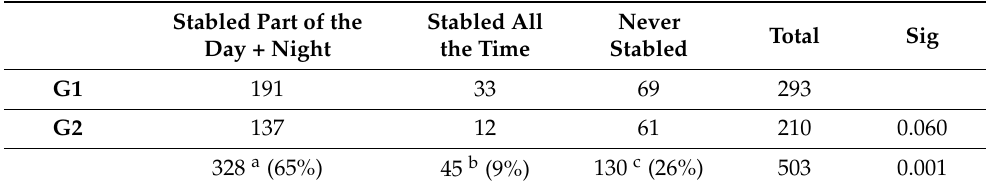
Table 2. Stabling and turn out regimens of both Group 1 (15–40 y old) (G1) and Group 2 (41+ y old) (G2) UK horse owners. Stabled Part of the Stabled All Never Total Sig Day + Night the Time Stabled G1 191 33 69 293 G2 137 12 61 210 0.060 328 a